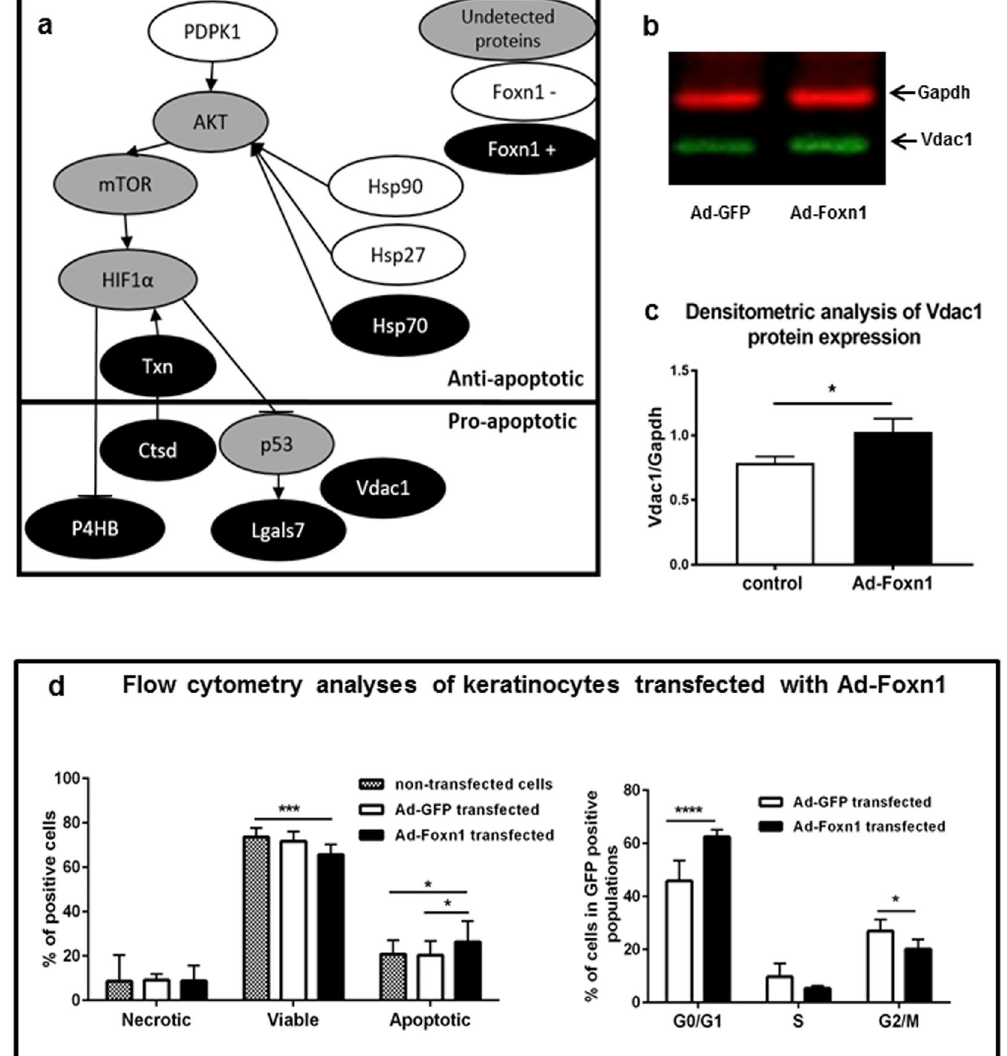
Figure 4. Foxn1 overexpression in keratinocytes affects pro-survival and pro-apoptotic protein profiles. Schematic representation of molecular cross-talk between proteins exhibiting pro- or anti-apoptotic characteristics, according to proteome profiling results, and induced in keratinocytes transfected with Ad-Foxn1 (black colour) or Ad-GFP controls (white colour) ( a ). Grey colour indicates proteins that were not detected in the analysis but link identified proteins ( a ). Representative Western blot ( b ) and densitometric analysis ( c ) (n = 4) of Vdac1 protein expression in keratinocytes transfected with Ad-GFP (control) or Ad-Foxn1. Full- length blots are presented in Supplementary Fig. S6. Flow cytometric analysis of keratinocytes transfected with Ad-Foxn1 or Ad-GFP (control) showing the percentages of necrotic, viable and apoptotic cells and cells in G0/ G1, S or G2/M phase ( d ). The values are the mean ± SD; * p < 0.05, *** p < 0.001; **** p <